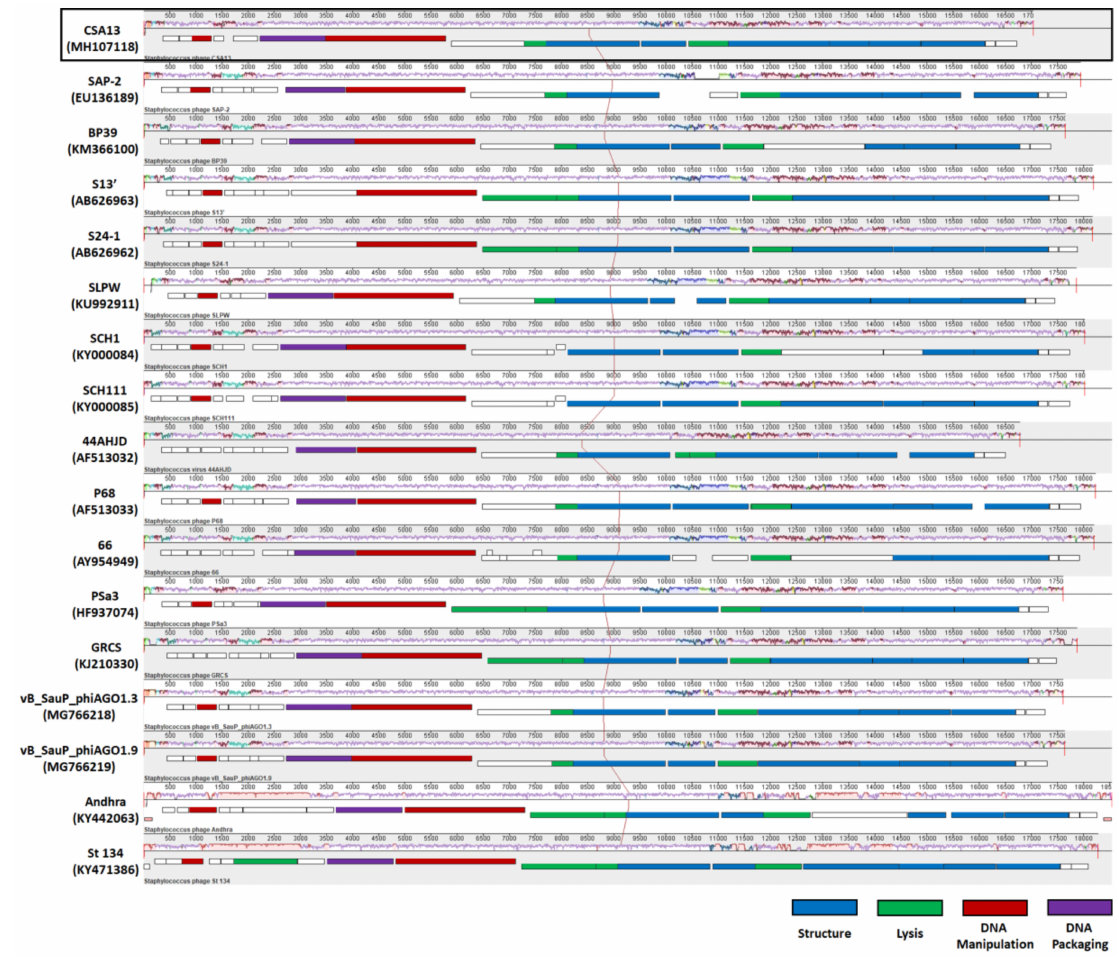
Figure 6. Multiple alignment of staphylococcal Podoviridae phage genomes by progressiveMauve. A total of 17 complete genomes were aligned; the genomes of phage CSA13 and phage 66 were annotated in an opposite direction to others; thus, the reverse complementary sequence was used. The GenBank accession number of each sequence is indicated. COG assignments for each ORF are represented in different colors, while the ORFs with unknown functions are depicted as blank